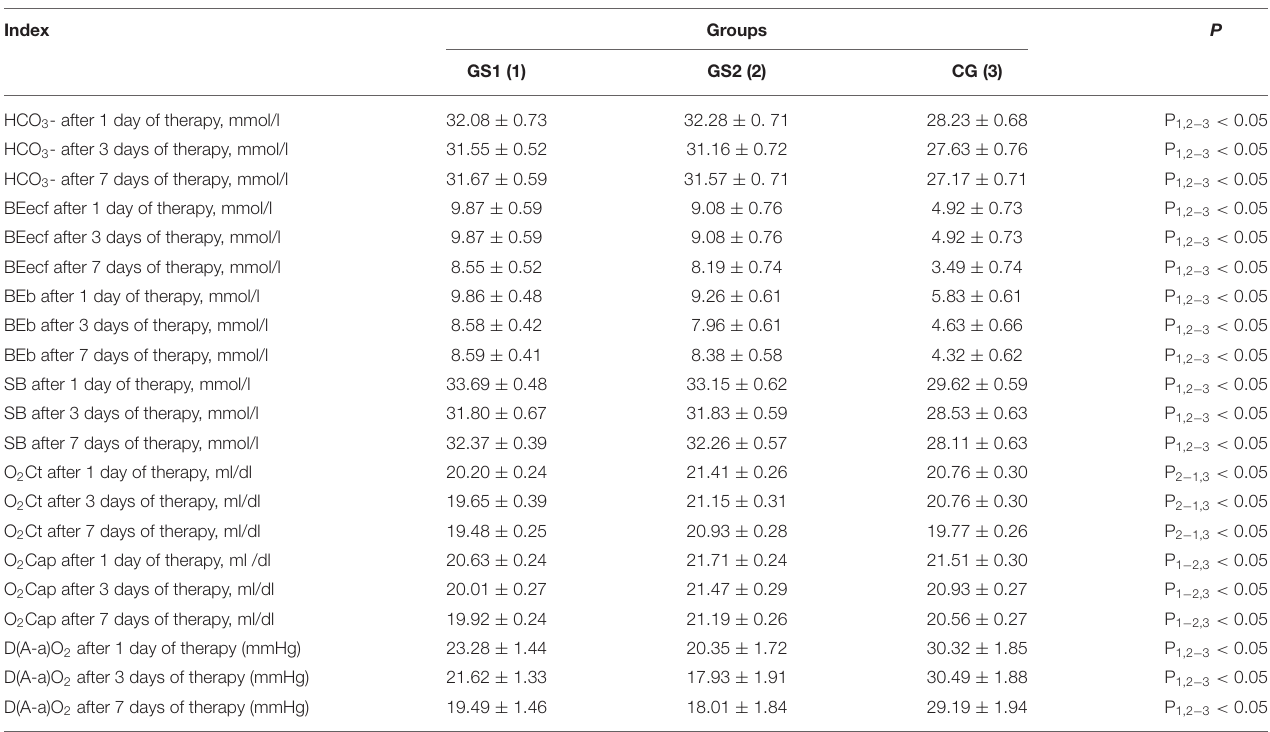
TABLE 2 | The dynamic changes of the acid-base state